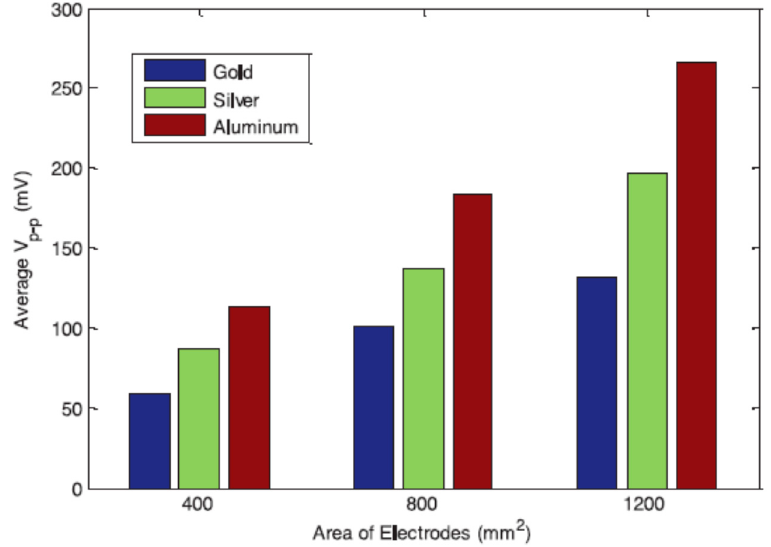
Figure 12. Average peak to peak open circuit voltage output for 400 mm 2 , 800 mm 2 , and 1200 mm 2 gold, silver and aluminum electrodes coated on EAPap [108].